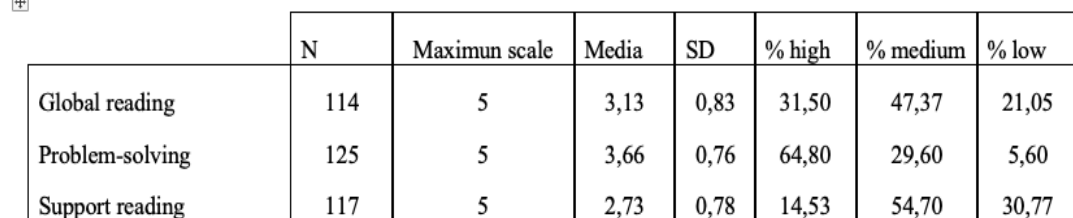
Table 5. Descriptive statistics and levels of frequency of use of reading strategies.